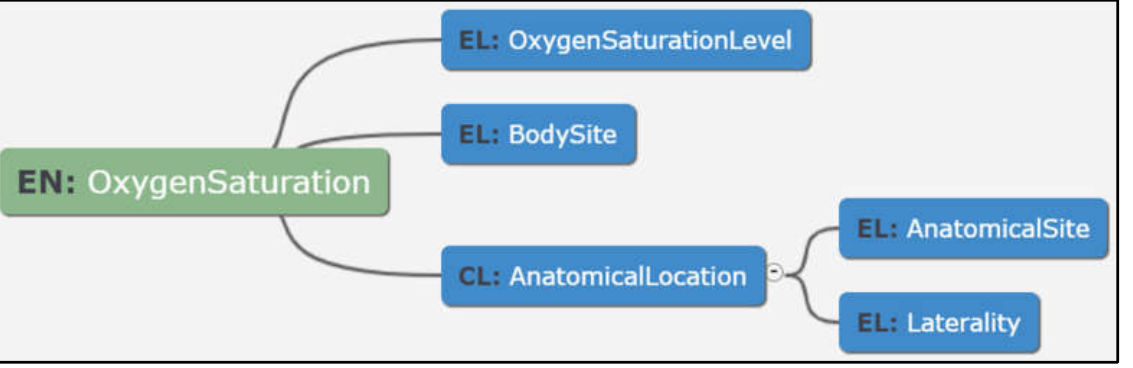
Figure 10. Modelled data dictionary item of oxygen saturation.